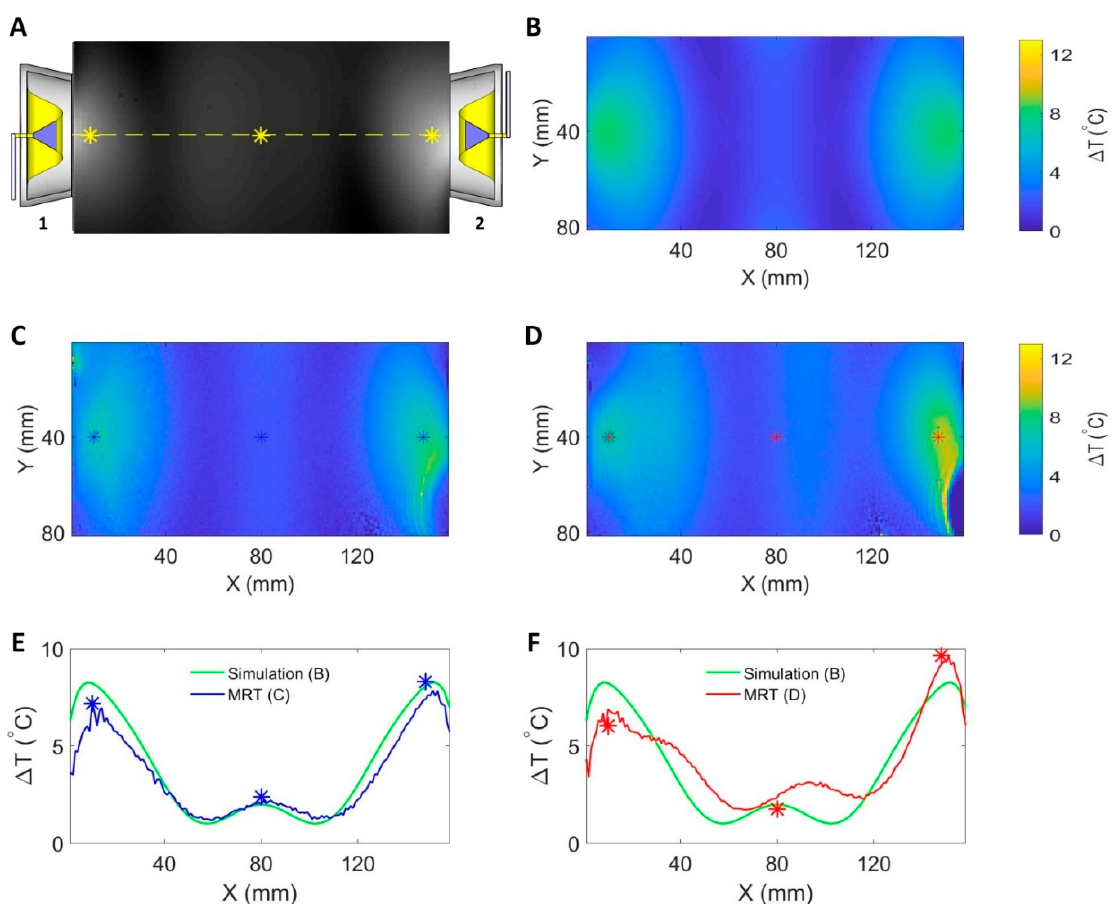
Figure 7. Summary of RF induced temperature changes ( ∆ T) obtained from numerical simulations and experiments (f = 400 MHz, t = 10 min, and P in at port = 17.78 W) with each RFPA being connected to an SGBT antenna. ( A ) The position of the antennas and an axial MR image through the center of the phantom. The yellow line indicates the coronal centerline. The yellow stars mark the positions of the fiber optic temperature sensors. A transversal slice in the middle of the phantom aligned with the center of the RF applicator was selected for data analysis. ( B ) The temperature changes obtained from the temperature simulation. The middle row shows maps of temperature changes derived from MR thermometry for RF heating with ( C ) and without ( D ) the supervision module in the control loop regulating the RF signals. The stars in ( C , D ) indicate the positions of the fiber optic temperature sensors. The bottom row depicts ∆ T profiles obtained for the centerline drawn through the center slice of the phantom for temperature simulations ( B ), experimental RF heating with ( C ) and without ( D ) the supervision module in the control loop. The blue and red stars indicate readings from the temperature sensors. A constructive interference pattern that was similar to the simulation result was observed in the middle of the phantom when the supervision module was activated in the loop ( E ). The interference pattern was distorted when the supervision module was not in the loop ( F ). For this case, the peak of the experimental interference pattern was shifted 16 mm to the right versus the reference obtained from the temperature